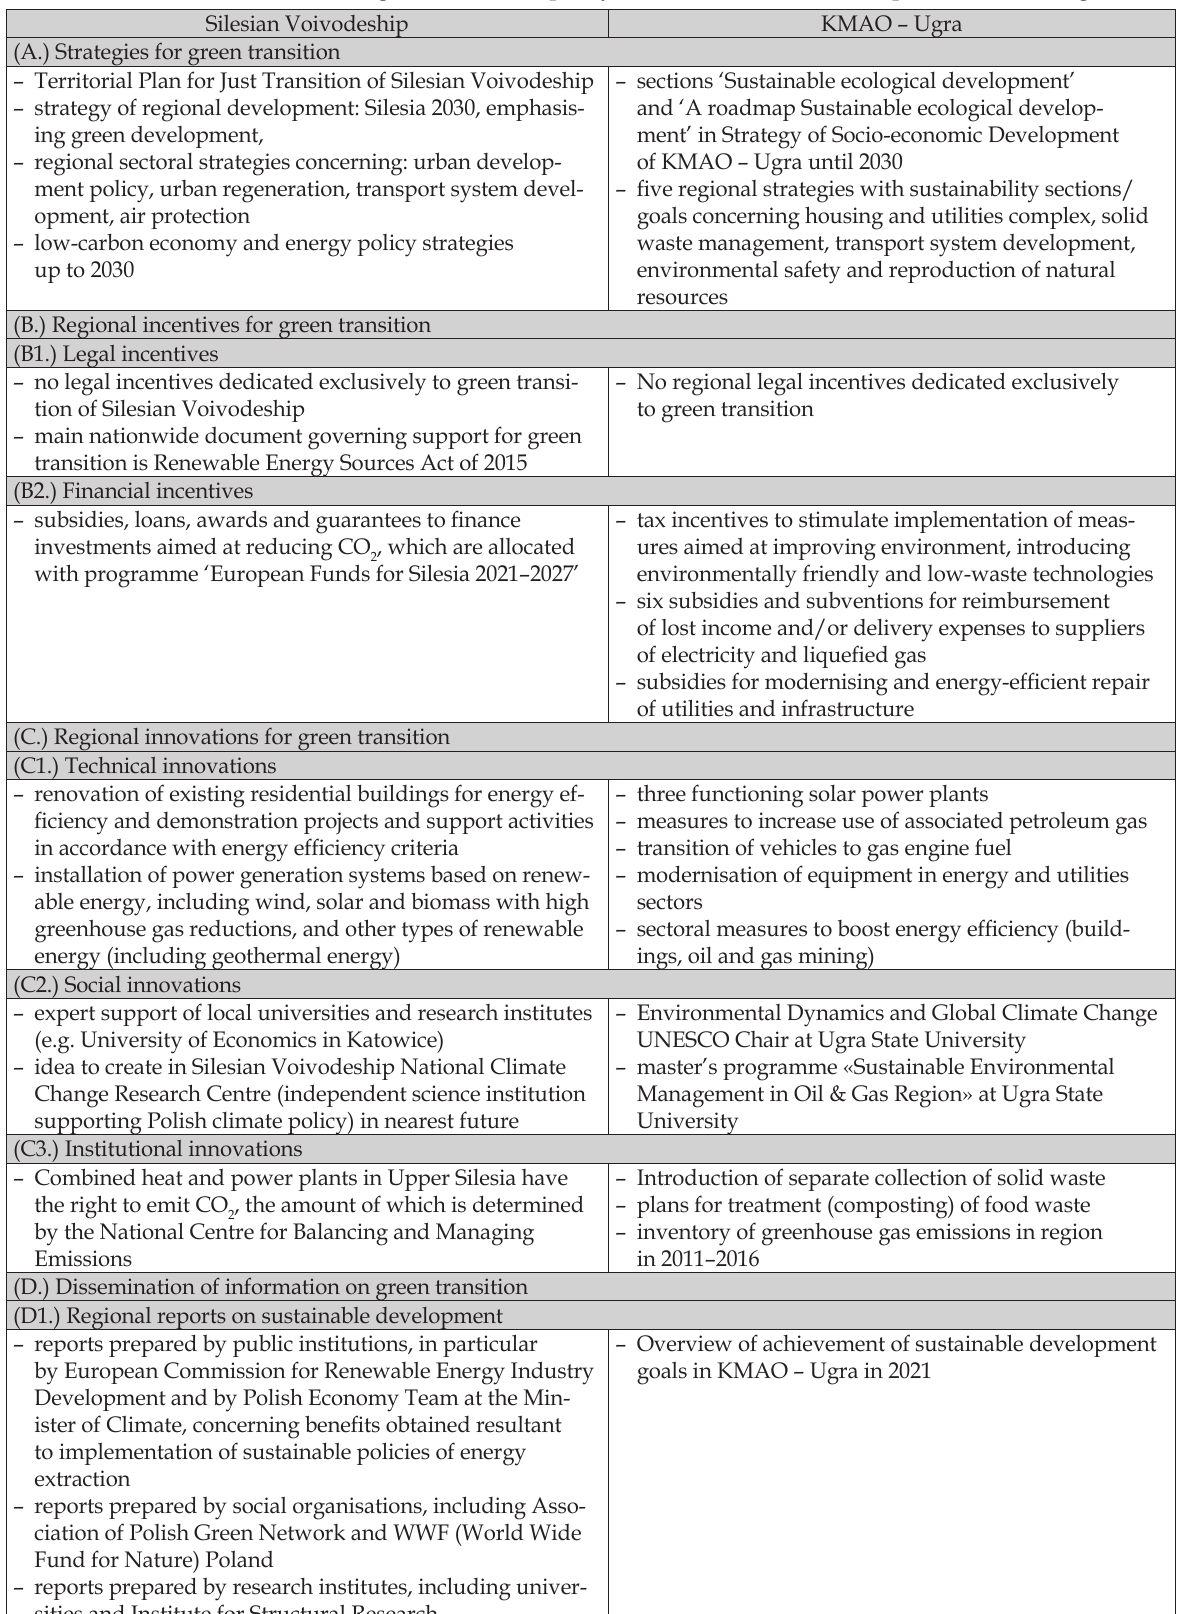
Table 1. Characteristics of the green transition policy in the Silesian Voivodeship and KMAO –